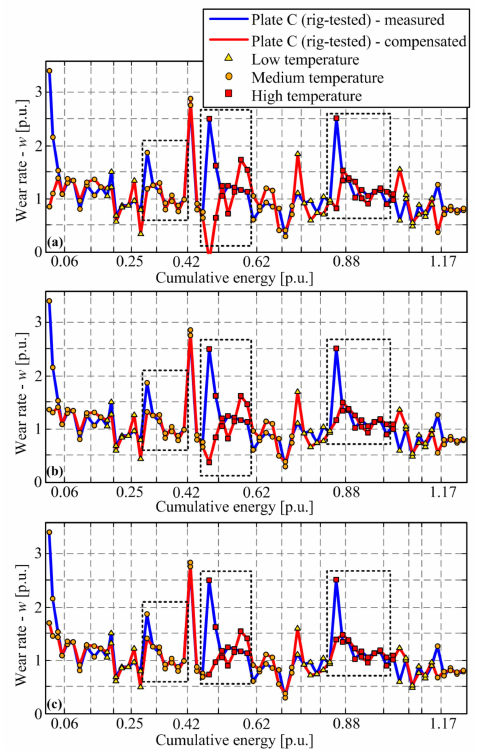
Figure 11. Comparison of non-compensated and compensated wear rate for Plate C when applying factor 1/1 ( a ), 1.25 ( b ) and 1/1.5 ( c ) instead of the “default” value 1/2 in Equation